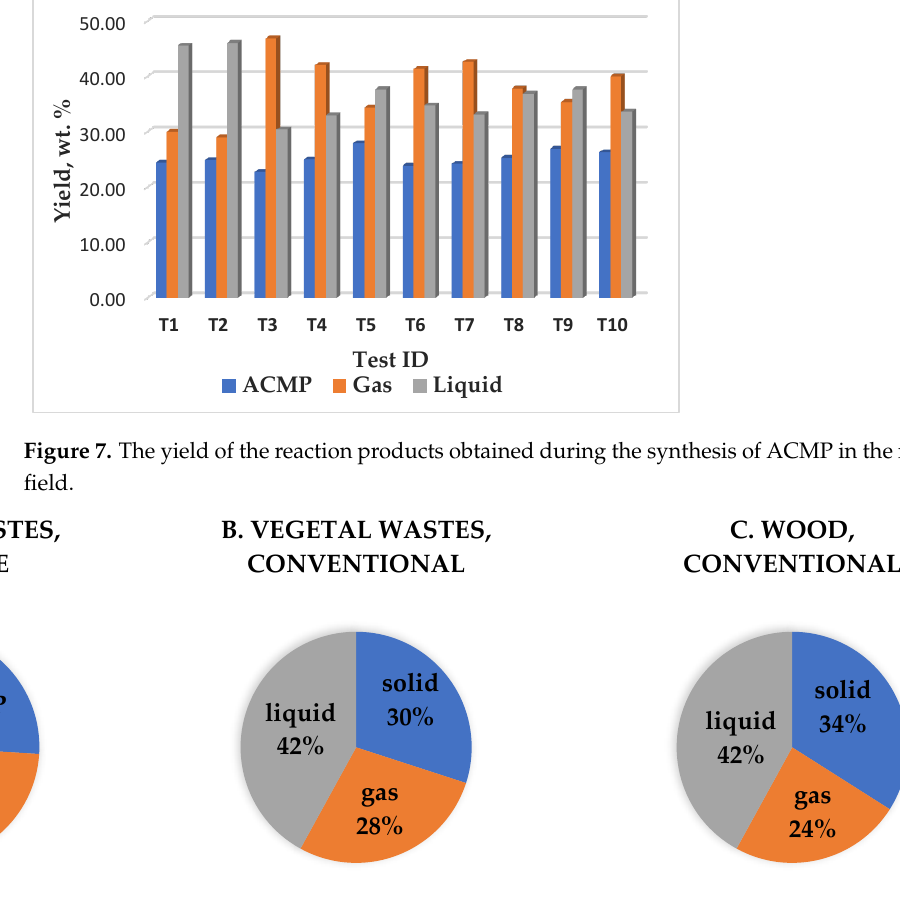
Figure 6. The thermal profile of the ACMP synthesis in the microwave field. The yield and characteristics of the pyrolysis products are strongly influenced by the operating conditions (e.g., temperature, heating rate) and the properties of the feedstock. The average yields obtained from ACMP synthesis of 26% biochar, (Figures 7 and 8A) are comparable to those mentioned in the literature of 27% in the case of wood [84]. The lignocellulosic nature of the waste favors obtaining by conventional pyrolysis global yields (biochar 30%, tar 42% and gases 28%) such as those obtained in the case of wood (biochar 34%, tar 42%, and gases 24%), (Figure 8); the use of this feedstock being considered appropriate to obtain ACMP by pyrogenation technology.